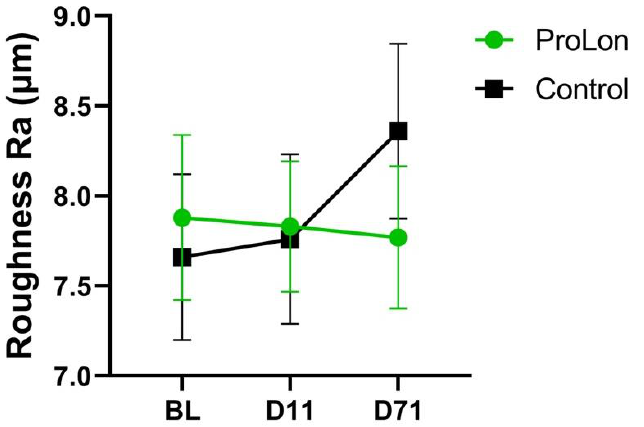
Figure 3. Skin Roughness Changes. The skin roughness was followed over the course of the study period in both the treatment and control groups.